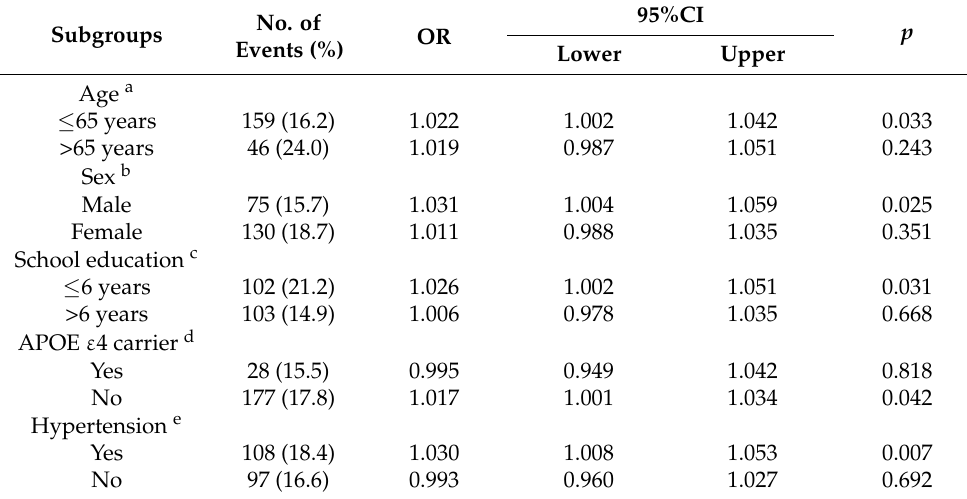
Table 5. Subgroup analysis of relationship between PP and cognitive decline.